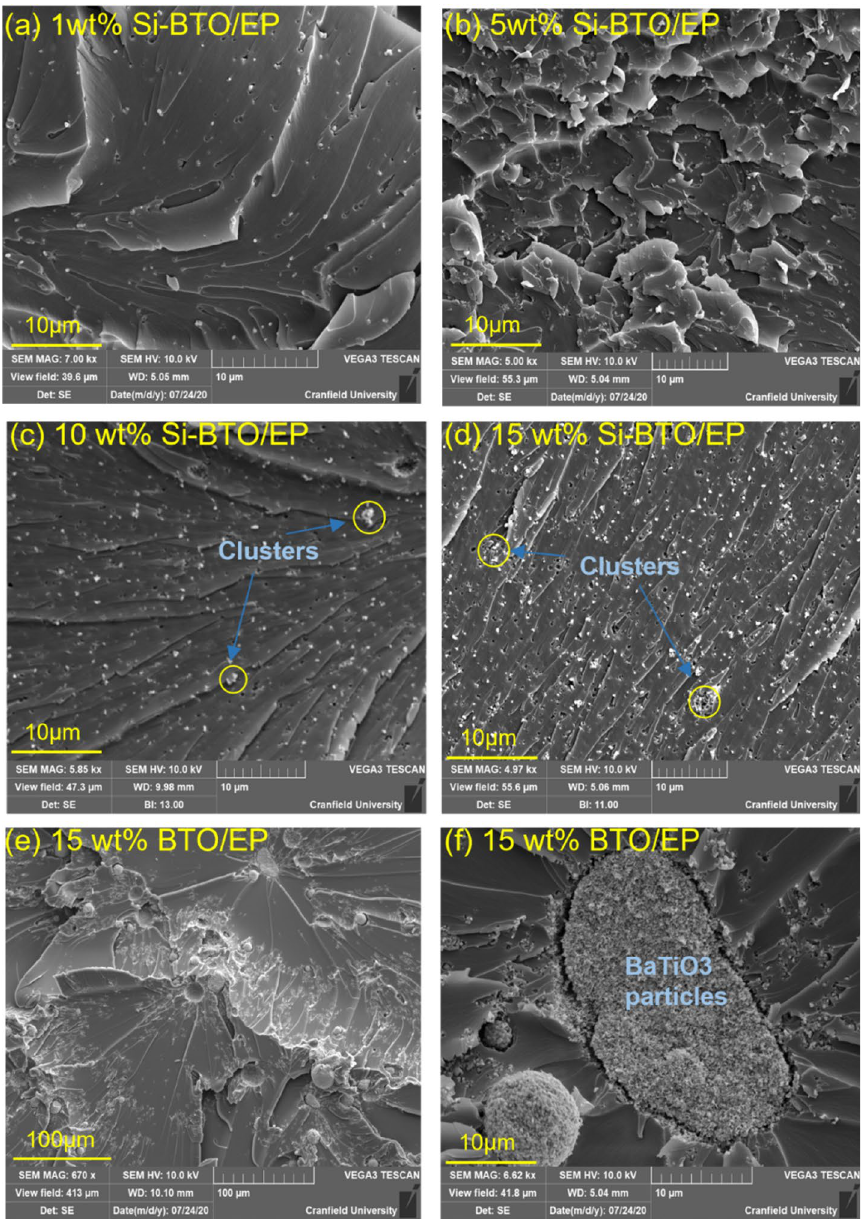
Figure 13. SEM images of fracture cross of epoxy nanocomposites with BaTiO 3 at different weight loading, ( a )–( d ) images of 1 wt.%, 5 wt.%, 10 wt.% and 15 wt.% Si-BaTiO 3 /Epoxy nanocomposite samples. ( e ) and ( f ) 15 wt.% untreated-BaTiO 3 -epoxy nanocomposite at lower (670x) and higher (6620x)